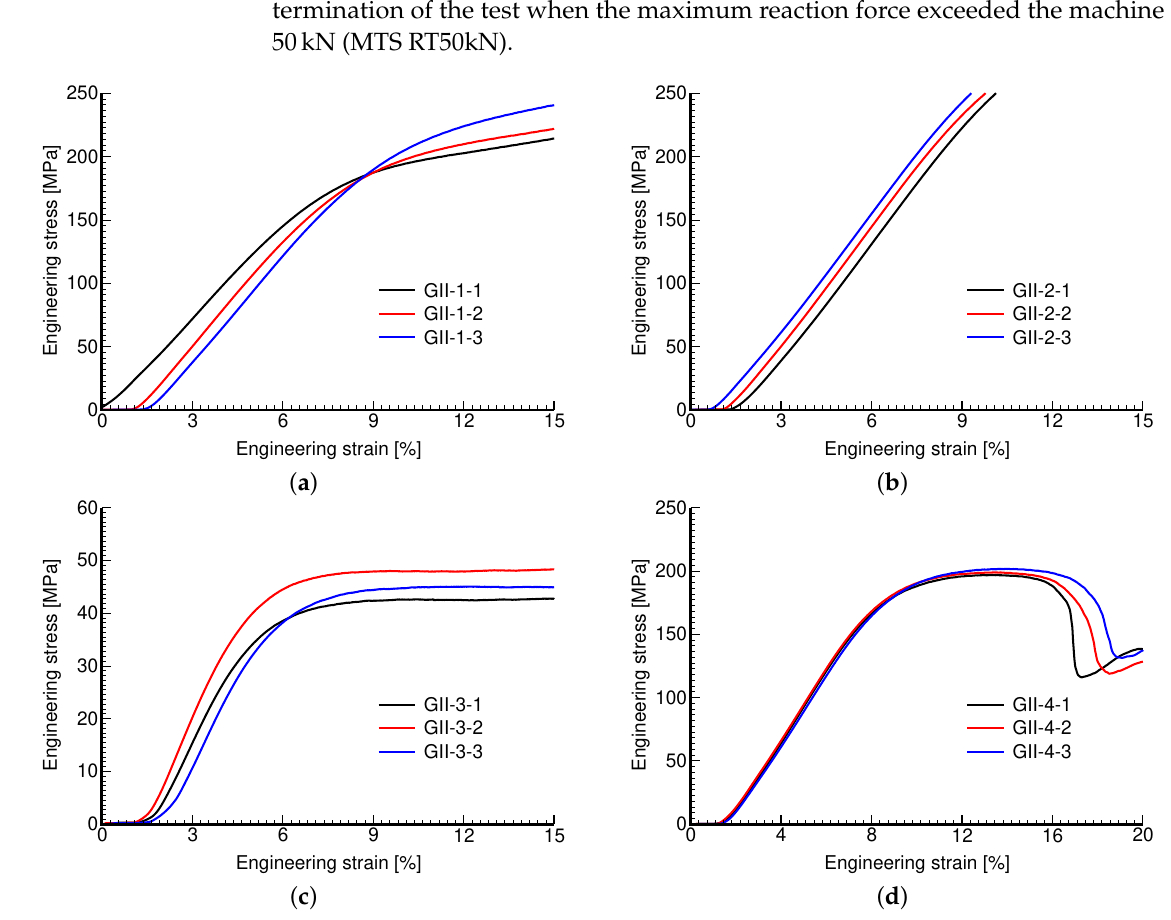
Figure 12. Engineering stress vs. engineering strain curves: ( a ) GII-1, ( b ) GII-2, ( c ) GII-3, ( d )